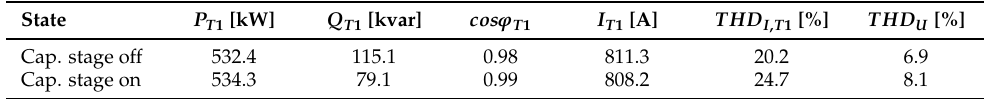
Table 2. C2: Electrical quantities on the low-voltage side of the transformer